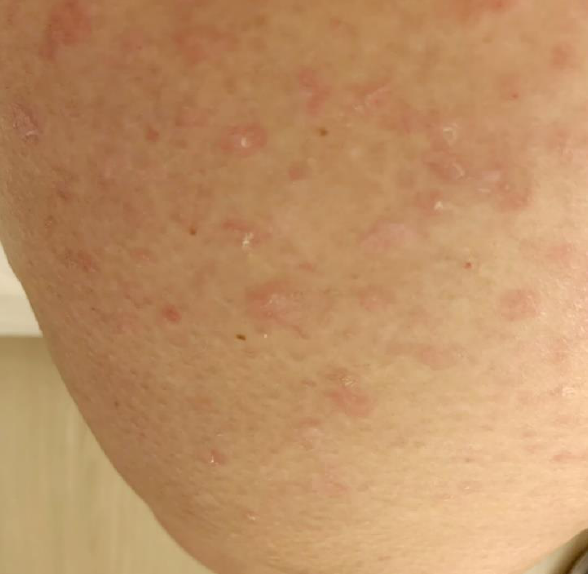
Figure 1. A female patient with scaly reddish-pinkish maculopapules on the right thigh. Clinically, we suspected PL chronica. However, histopathology revealed hyperparak- eratosis and prominent epidermotropism of atypical lymphocytes forming Pautrier’s mi- croabscesses (Figure 2). Immunohistochemically, the infiltrating lymphocytes were mainly positive for CD8 (Figure 3) with the coexpression of CD3 and CD5 and an almost complete loss of CD7 expression. CD20 and CD30 were not